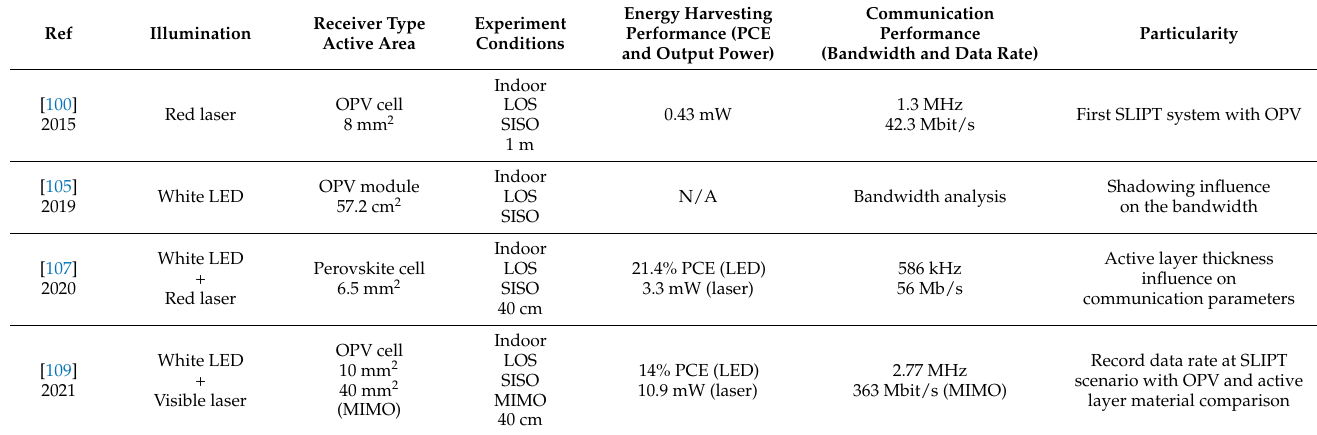
Table 4. Summary of some of the most impactful contributions for SLIPT-based systems (with emerg- ing PV technologies) with their respective information about the illumination, receiver characteristics (PV technology, type of device, and active area size), experiment condition (type of link and dis- tance between Tx and Rx), energy harvesting parameters (PCE and output power), communication performance (bandwidth and data rate), and most notable